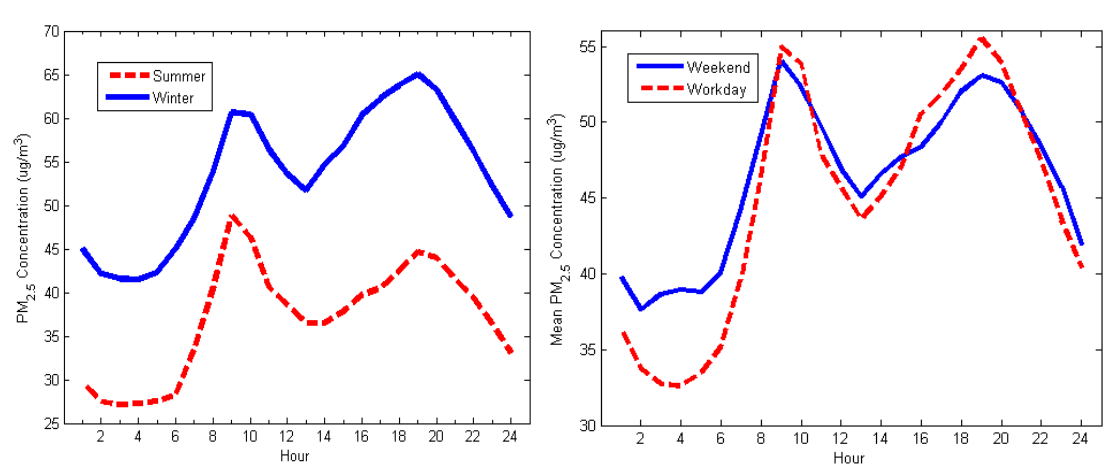
concentrations ( left ) during summer and winter; and 2.5